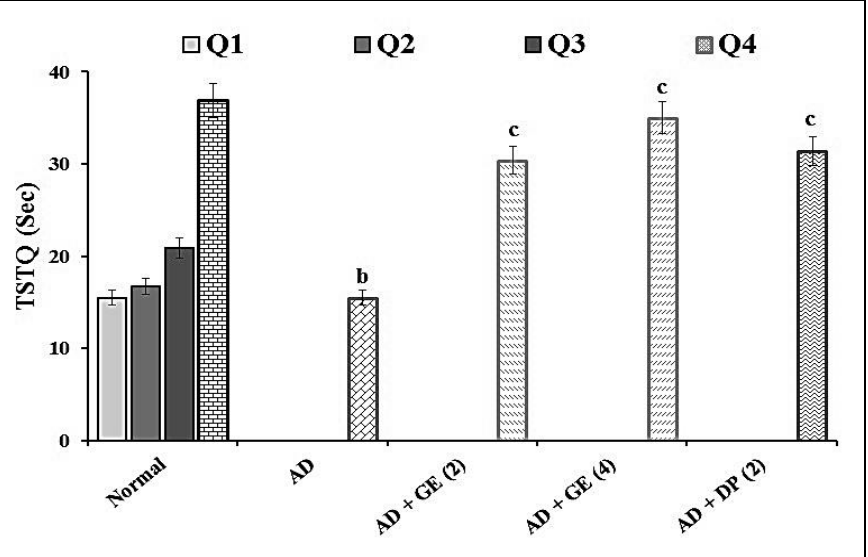
Figure 2. Effect of GE on TSTQ in MWM test assessment. Digits in parentheses indicate the dose in mg/kg. Data are expressed as the mean ± SD, n = 8 mice per group. a p < 0.05 vs. Q 1 normal group; b p < 0.05 vs. Q 4 normal group; c p < 0.05 vs. AD group. Abbreviations : AD, Alzheimer’s disease; DP, donepezil; GE, gefitinib; Q, quadrant; Sec, seconds; TSTQ, time spent in the target quadrant.